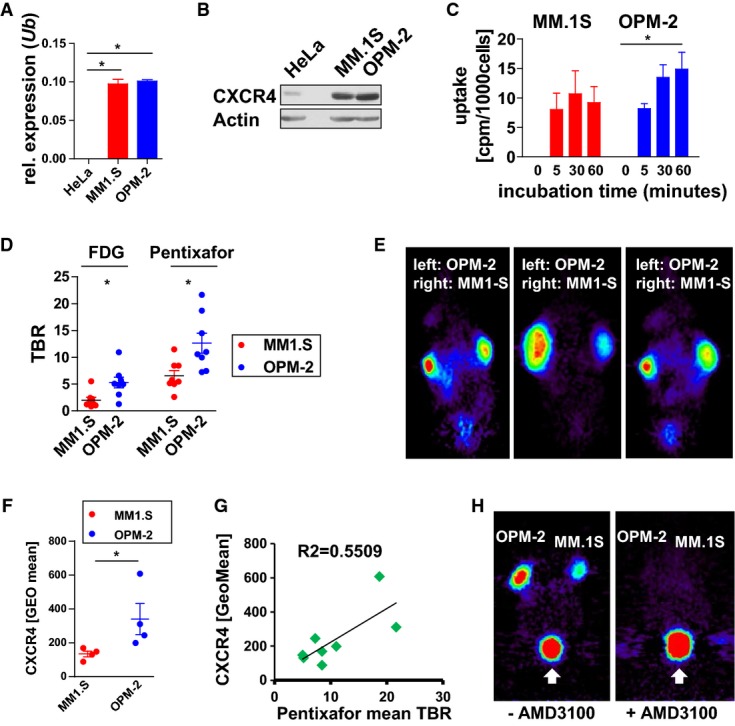
[68Ga]Pentixafor PET imaging of MM xenografts
Real-time PCR analysis of cxcr4 transcript expression levels in HeLa (negative control) and in MM cell lines MM.1S and OPM-2. Shown is the mean relative expression ± SEM (n = 3 independent experiments). Values are normalized to the expression of ubiquitin (Ub). The asterisk indicates statistically significant differences (HeLa vs MM.1S: P < 0.001; HeLa vs OPM-2: P < 0.0001; Student's t-test).

CXCR4 protein expression assessed by immunoblotting (one representative blot out of 3 is shown).

Binding of [68Ga]Pentixafor to MM.1S and OPM-2 cells after the indicated incubation periods (n = 3 per cell line and time point). Shown is the mean ± SEM. The difference between the OPM-2 groups is statistically significant; *P < 0.0017 (one-way ANOVA).

Mean tumor-to-background ratio (TBR) for [18F]FDG (left) and for [68Ga]Pentixafor (right) in MM.1S and OPM-2 xenograft-bearing NOD SCID mice. Shown is the mean ± SEM, n = 8 tumors (4 mice); *P = 0.0111 for [18F]FDG and *P = 0.0113 for [68Ga]Pentixafor (Student's t-test). One-way ANOVA revealed significant differences between the groups; P < 0.0001 (not graphically shown).

Representative [68Ga]Pentixafor PET images of three mice bearing MM.1S (right shoulder) and OPM-2 (left shoulder) tumors.

Flow cytometric quantification of CXCR4 cell surface expression on resected MM.1S and OPM-2 tumors. Data are the mean ± SEM, n = 4. *P = 0.0286; Mann–Whitney U-test.

Correlation of [68Ga]Pentixafor PET mean TBR and CXCR4 cell surface expression assessed by flow cytometry. n = 8 tumors were analyzed.

Mice (n = 4) bearing OPM-2 and MM.1S xenografts were coinjected with AMD3100 (right image, one representative mouse) or not pretreated (left image) before undergoing [68Ga]Pentixafor PET. The white arrows point to the bladder. Quantification is shown in Supplementary Fig S3A.
Source data are available online for this figure.